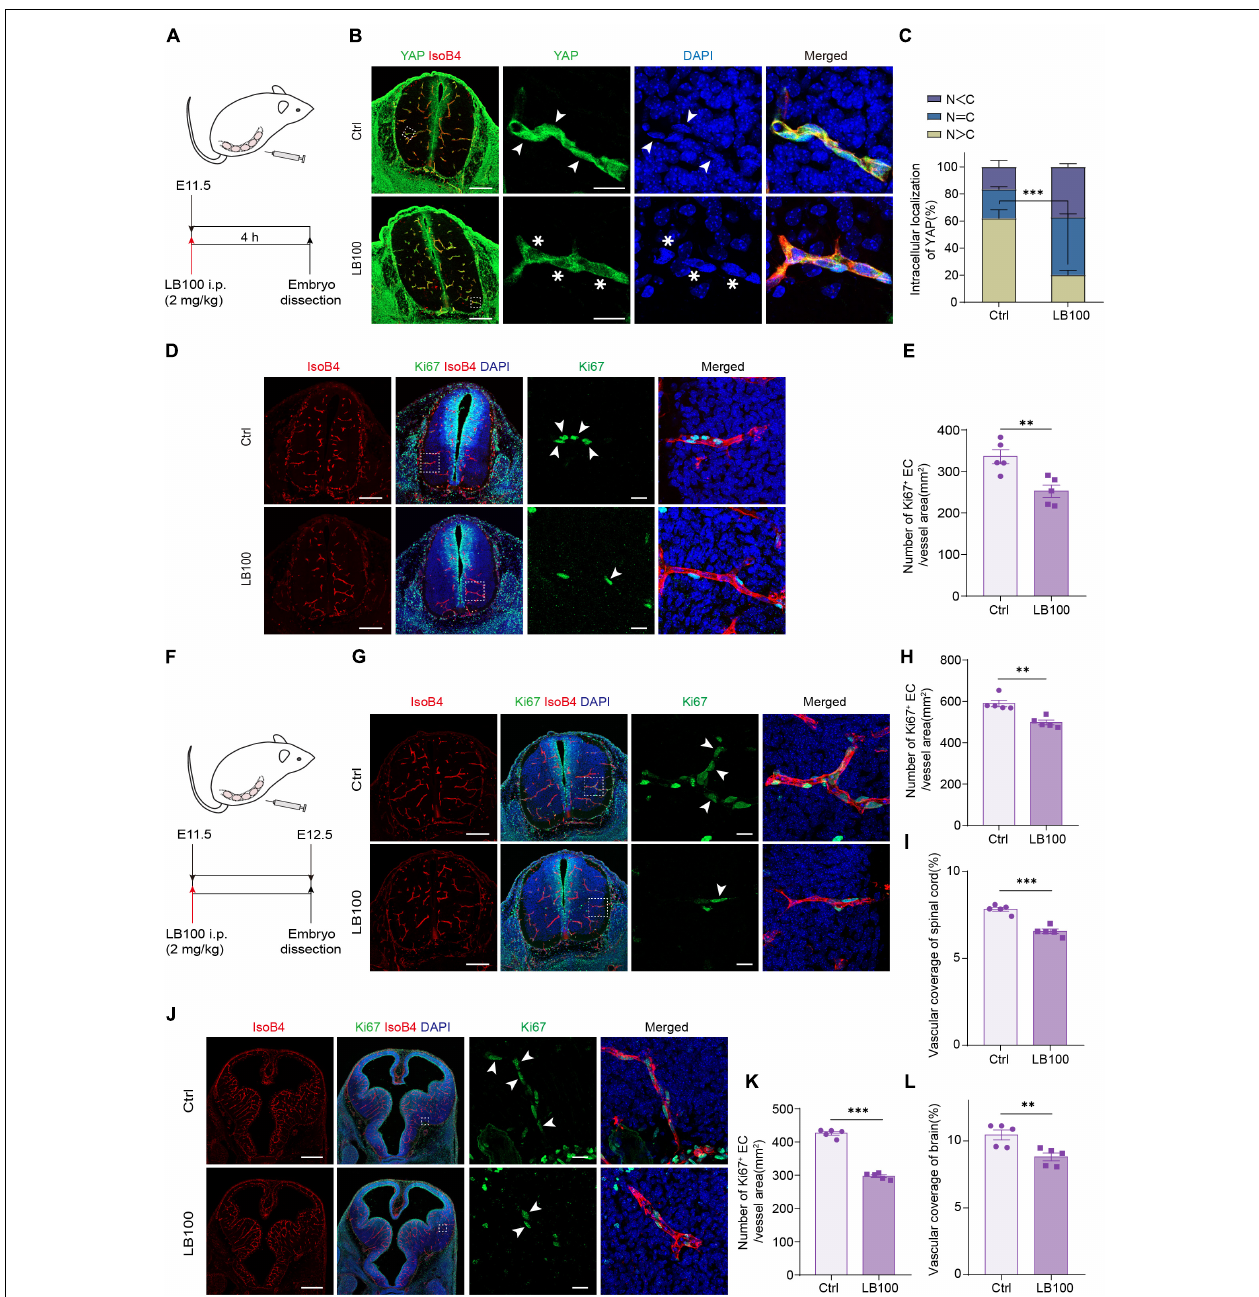
FIGURE 4 | PP2A inhibition impairs developmental vascularization in embryos. (A) Scheme of LB100 injection in pregnant females. (B) Representative confocal images of spinal cord from mouse embryos treated as in (A) and stained for YAP, ECs (IsoB4), and nuclei (DAPI). Images are representative of 3 litters per condition. Arrowhead indicate nuclear YAP and asterisk indicate cytosolic YAP in ECs. (C) Quantification of YAP cellular localization in the spinal cord from embryos treated with vehicle or LB100 of (B) . N, nucleus; C, cytosol. n = 5 Vehicle and 5 LB100 embryos per condition. (D) Representative confocal images of spinal cord from embryos treated as in (A) and stained for Ki67, ECs (IsoB4), and nuclei (DAPI). Arrowhead indicate Ki67 positive ECs. Images are representative of 3 litters per condition. (E) Quantification of Ki67 positive ECs in the embryo spinal cord of (D) . n = 5 Vehicle and 5 LB100 embryos per condition. (F) Scheme of LB100 injection in pregnant females. (G) Representative confocal images of spinal cord from mouse embryos treated as in (G) and stained for Ki67, ECs (IsoB4), and nuclei (DAPI). Arrowhead indicate Ki67 positive ECs. Images are representative of 3 litters per condition. (H) Quantification of Ki67 positive ECs in the embryo spinal cord of (H) . n = 5 Vehicle and 5 LB100 embryos per condition. (I) Quantification of vascular coverage of the embryo spinal cord of (H) . n = 5 Vehicle and 5 LB100 embryos per condition. (J) Representative confocal images of brains from embryos treated as in (G) and stained for Ki67, ECs (IsoB4), and nuclei (DAPI). Arrowhead indicate Ki67 positive ECs. Images are representative of 3 litters per condition. (K) Quantification of Ki67 positive in brains of (K) . n = 5 Vehicle and 5 LB100 embryos per condition. (L) Quantification of vascular coverage ECs of (K) . n = 5 Vehicle and 5 LB100 embryos per condition. Data are shown as mean ± SEM, two tailed Student’s t -test. ∗∗ p < 0.01 and ∗∗∗ p < 0.001. Scale bars, 200 µ m (lower magnification) and 20 µ m (insets) in (B,D,G) , 500 µ m (lower magnification) and 20 µ m (insets) in (J) .